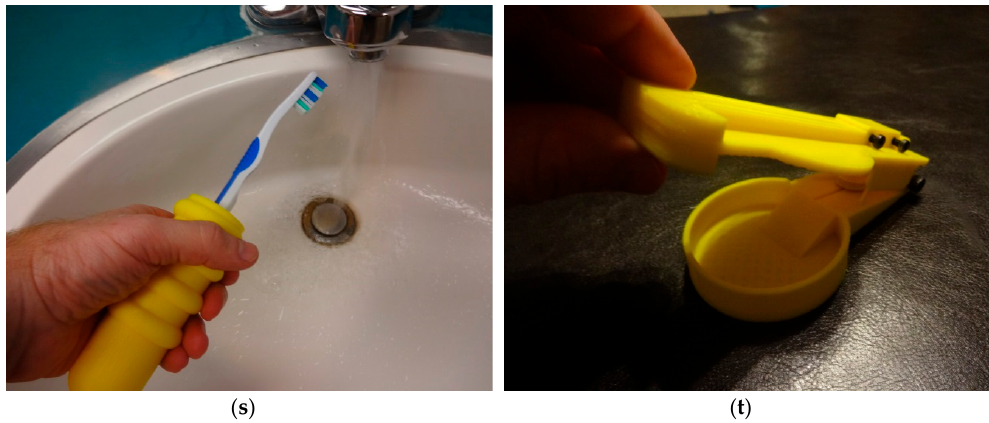
Figure 1. Twenty selected case ‐ study arthritis adaptive aids from Table 1 ( a ) scissor aid; ( b ) car seat aid; ( c ) drawer aid; ( d ) light switch aid; ( e ) sock aid; ( f ) knife guide aid; ( g ) phone holder aid; ( h ) zipper pull aid; ( i ) knitting aid; ( j ) pen holder aid; ( k ) nail clipper aid; ( l ) cane holder aid; ( m ) key aid; ( n ) typing aid; ( o ) pop can aid; ( p ) dog leash aid; ( q ) gas cap aid; ( r ) handle adapter aid; ( s ) toothbrush aid; ( t ) pill splitter aid.